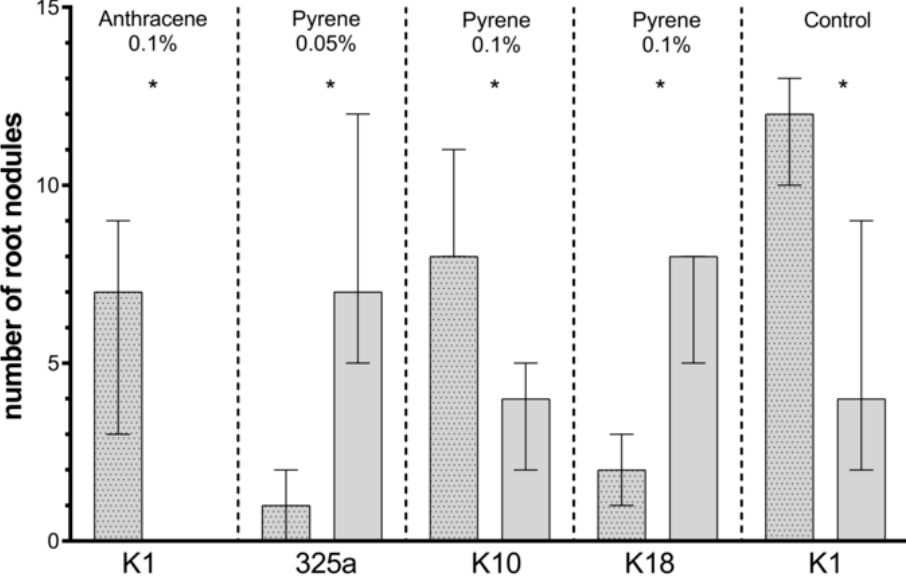
Figure 7. Comparison of the e ff ect of inoculation of clover with only R. leguminosarum strains and with co-inoculation with A. brasilense on number of root nodules. The dotted posts indicate the co-inoculation with the A. brasilense variant. The results are presented as a boxplot with median and 2.5–97.5 percentile. The symbols indicate significant results at: * p ≤ 0.05; ** p ≤ 0.01; *** p ≤ 0.001; α = 0.05. Figure presents only those strains for which statistically significant differences were noted.